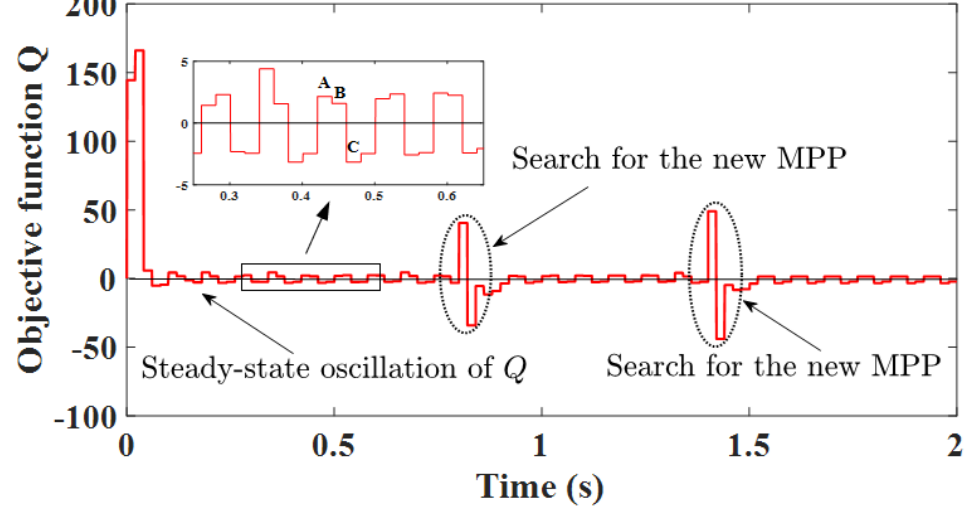
Figure 12. Oscillation of Q around zero during MPP tracking. Energies 2022 , 15 , x FOR PEER REVIEW